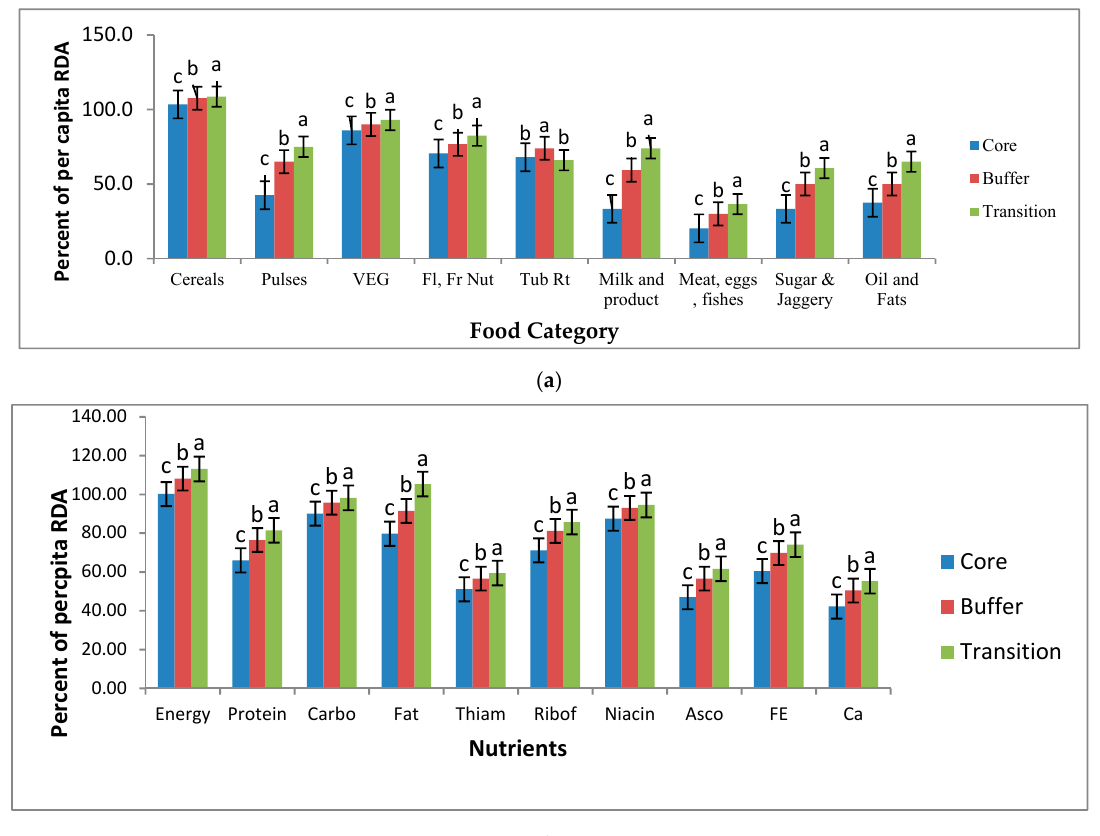
Figure 5. ( a ): Per capita intake of food categories as percent of recommended dietary allowances (RDA) by indigenous communities in AABR, Central India, Different letters denoted on bars for each category of foods are statistically different at p ≤ 0.05 (N = 332; ±SEm of percentages). ( b ): Per capita intake of nutrients as percent of RDA by indigenous communities in AABR, Central India, Different letters denoted on bars for each category of nutrients are statistically different at p ≤ 0.05 (N = 332; ±SEm of percentages). Note: Carbo—carbohydrates, Thiam—thiamne, Ribof—riboflavin, Asco—ascorobic acid, Fe—iron, Ca—calcium. Table 3. Per capita food groups intake (consumption- g/day) pattern of Indigenous communities in AABR, Central India.